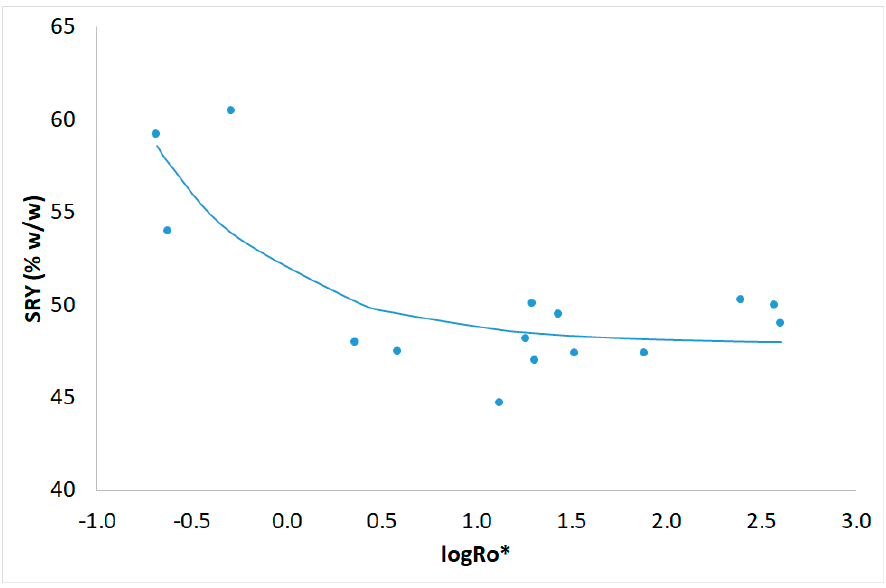
Figure 2. SRY of the ACWT-treated material as affected by the CSF.